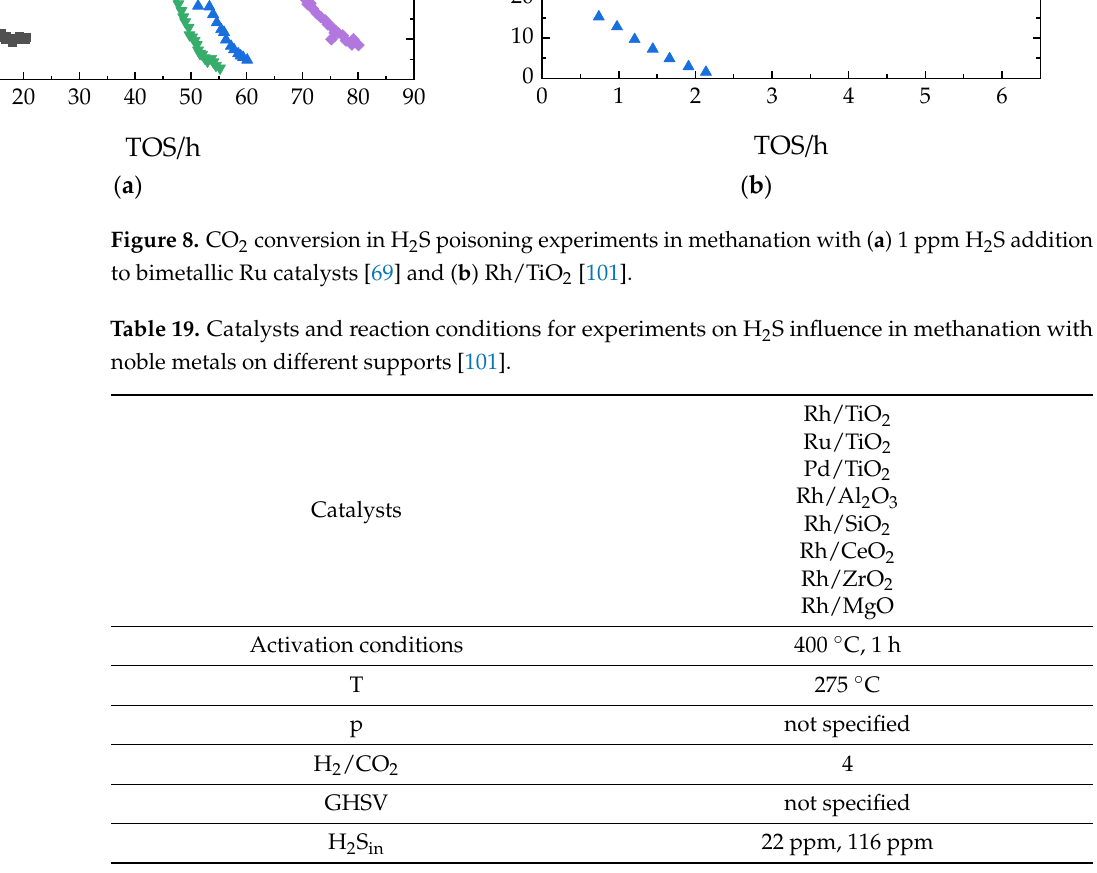
Table 19. Catalysts and reaction conditions for experiments on H 2 S influence in methanation with noble metals on different supports [101].